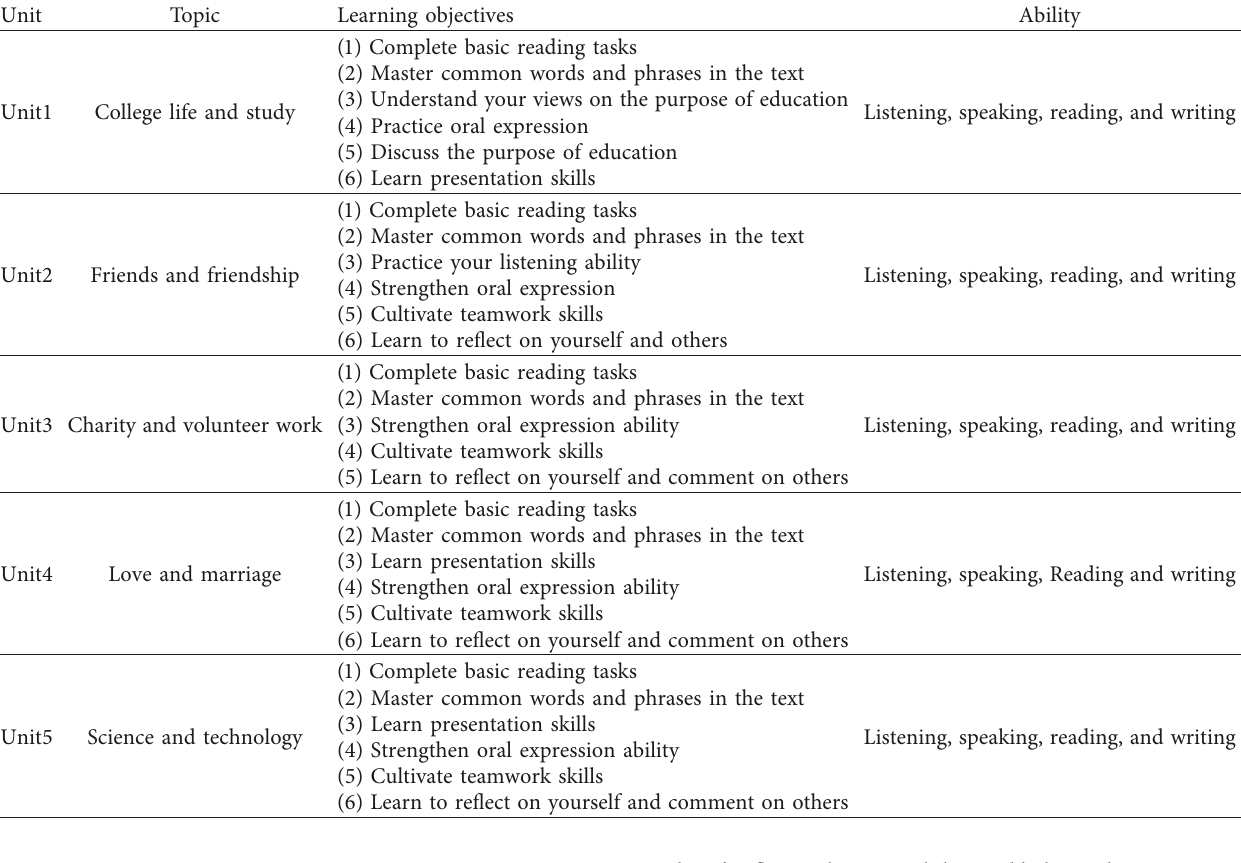
Table 7: Learning objectives of Advanced Oral English.